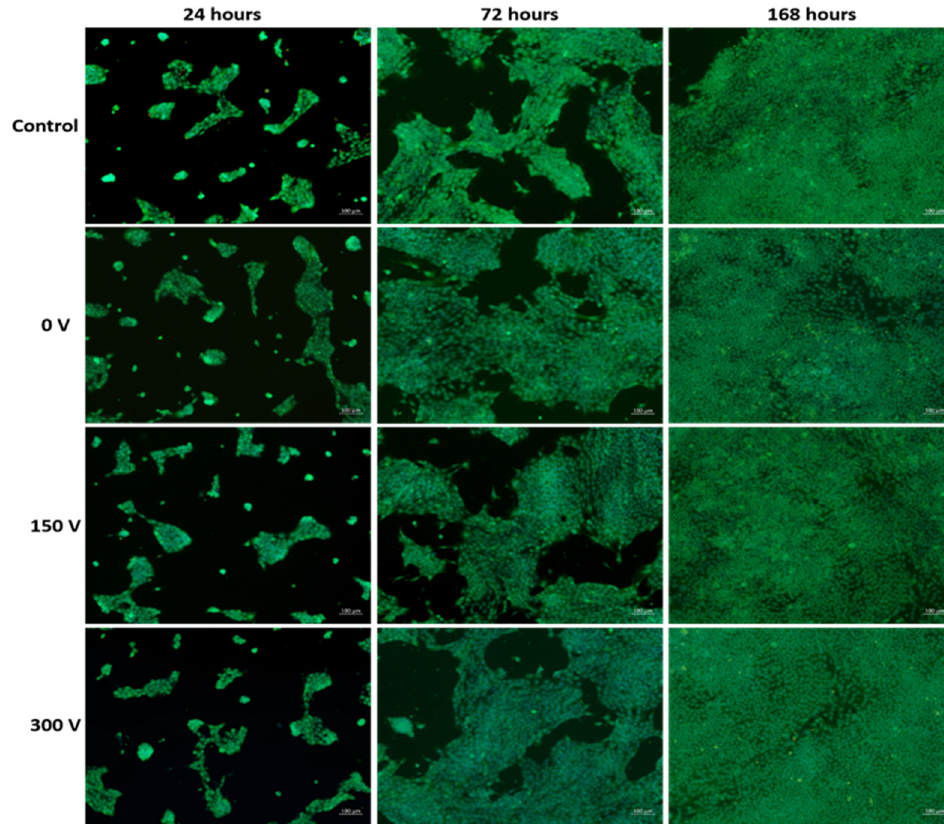
Figure 5. Images of the fluorescently labeled fibroblasts after 24, 72 and 120 h of cultivation with sample extracts. Table 4. Results of testing the cytotoxicity of obtained membranes after 24, 72, and 168 h of cultivation.